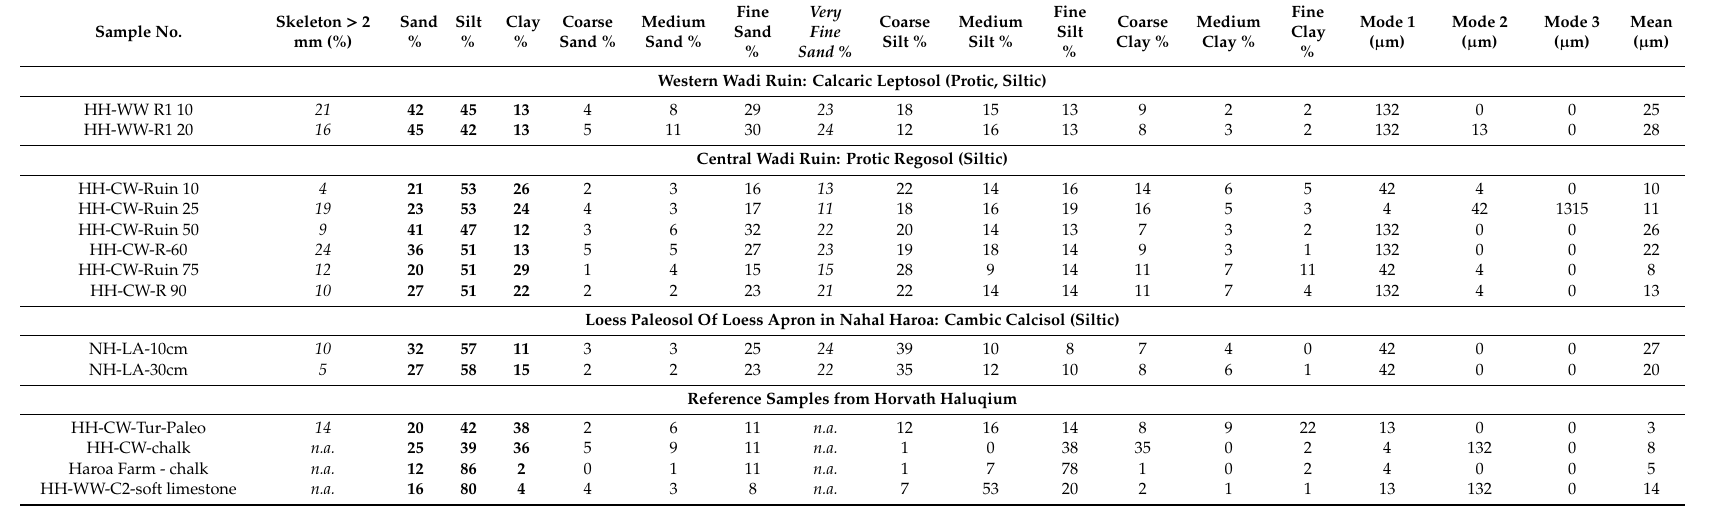
Table A2. Results of particle size analysis of the Negev samples with sieving and the Sedigraph and selected statistical parameters, such as the main modes and average grain size calculated with the Gradistat program. Note that the very fine sand (in italics) is part of the fine sand fraction. Skeleton is shown as well (in italics), and summarizing grain size units (in